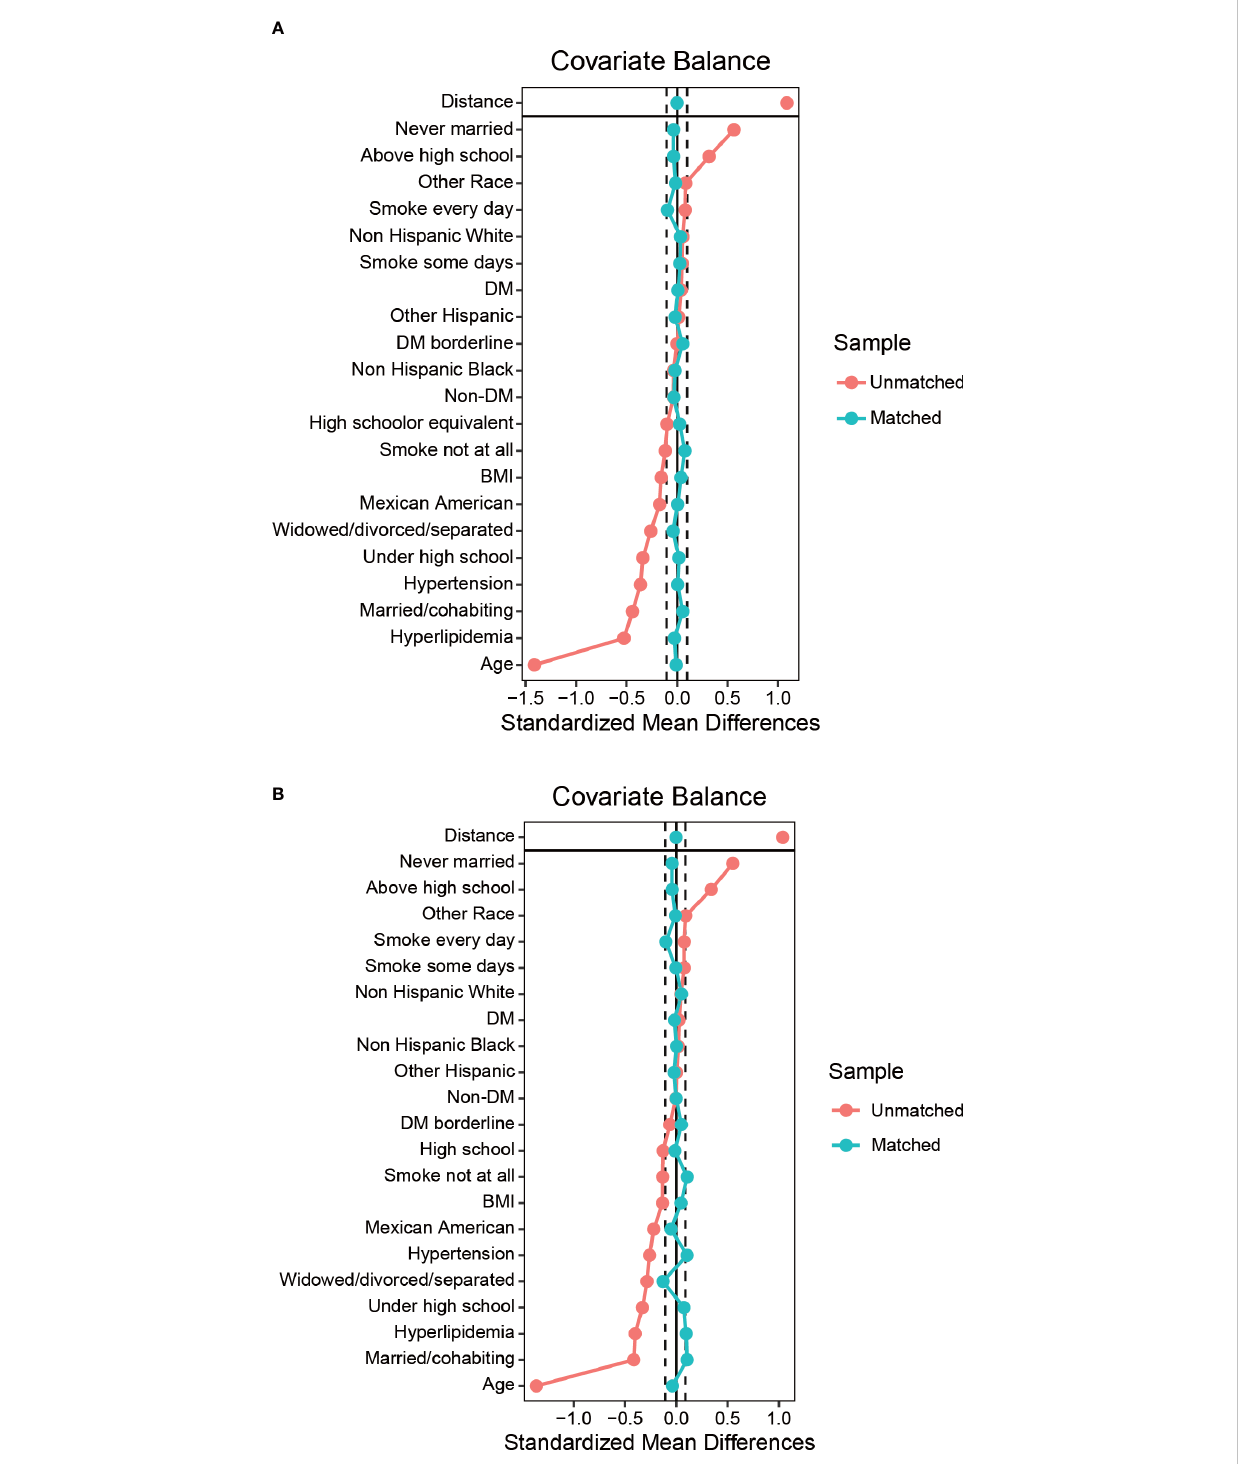
FIGURE 4 Balance diagnostics plot for HPV immunization data, before and after matching. (A) Standardized differences shown for each baseline confounder variable of HPV immunization cohort before weighting. (B) Standardized differences shown for each confounder variable of HPV immunization cohort after weighting. Vertical dotted lines indicate the desired balance level. The X-axis represents the standardized differences value, and the Y-axis represents baseline variables. HPV, Human papillomavirus; BMI, body mass index; DM, diabetes